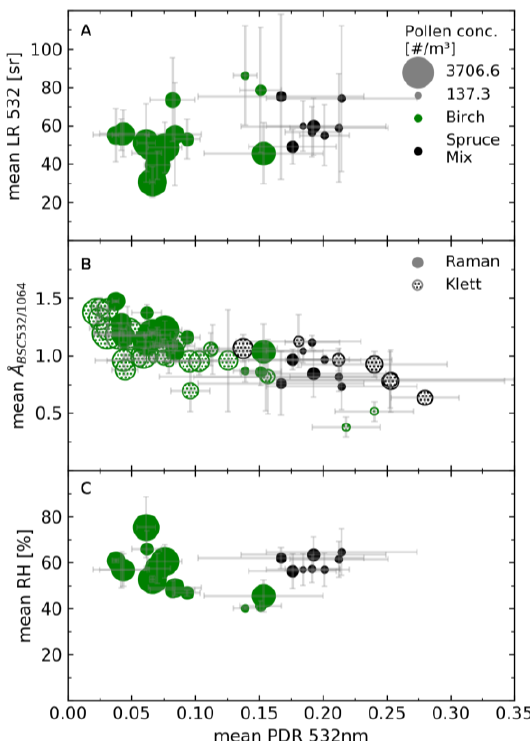
Figure 2 Layer mean values of lidar ratio at 532 nm (top), backscatter-related Ångström exponent at 532/1064 nm (middle) and relative humidity (bottom) against mean PDR at 532 nm. Error bars denote the standard deviation, size the pollen concentration and color the measurement